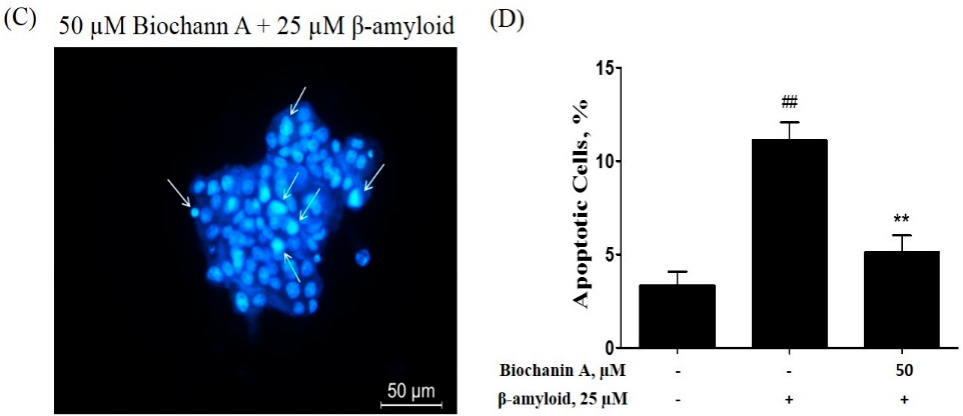
Figure 3. Effect of biochanin A on A β 25–35 -induced nuclear condensation. PC12 cells were treated with A β 25–35 (25 μ M) for 24 h in the presence or absence of biochanin A (50 μ M). The cells were observed by fluorescence microscopy after nuclei were stained with Hoechst 33342. ( A ) Control cells; ( B ) Cells treated with A β alone; ( C ) Cells treated with A β 25–35 and biochanin A (50 μ M). Arrows indicating the nuclei condensation and apoptotic bodies; ( D ) Five randomized representative fields from each group were analyzed in one experiment. Each value represents the mean ± S.E.M. relative to the control from four independent experiments. ** p < 0.01 compared with the group treated with A β 25–35 alone; ## p < 0.01 compared with the control group. “ − ”and “+”in the figure indicate “in the absent of” and “in the present of” respectively.